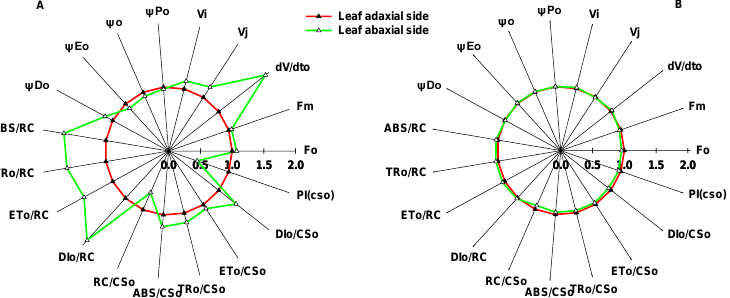
Figure 2. Differences in the JIP-test parameters between the adaxial and abaxial sides of sunflower ( A ) and sorghum ( B ) leaves. F o , minimal recorded fluorescence intensity; F m , maximal recorded flu- orescence intensity; V J , relative variable fluorescence intensity at the J-step; V I , relative variable fluorescence intensity at the I-step; dV/dto, Q A maximum reduction rate; ϕ Po , maximum quantum yield for primary photochemistry (at t = 0); ψ o , probability that a trapped exciton moves an electron into the electron transport chain beyond Q A − (at t = 0); ϕ Eo , quantum yield for electron transport (at t = 0); ϕ Do , quantum yield of energy dissipation (at t = 0); ABS/RC, absorption flux per reaction center (at t = 0); TR o /RC, trapped energy flux per reaction center (at t = 0); ET o /RC, electron trans- port flux per reaction center (at t = 0); DI o /RC, dissipated energy flux per reaction center (at t = 0); ABS/CS o , absorption flux per cross section (at t = 0); TR o /CS o , trapped energy flux per cross section (at t = 0); ET o /CS o , electron transport flux per cross section (at t = 0); DI o /CS o , dissipated energy flux per cross section (at t = 0); RC/CS o , density of Q A -reducing PSII reaction centers; PI CS , performance index on cross section basis (at t =